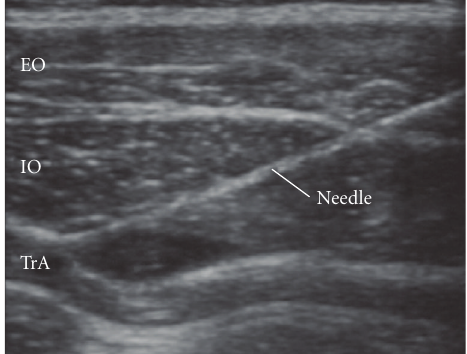
Figure 5: Ultrasound image during initial injection of a small amount of local anesthetic [9]. Reproduced with permission. EO: external oblique, IO: internal oblique, TrA: transversus abdominis.